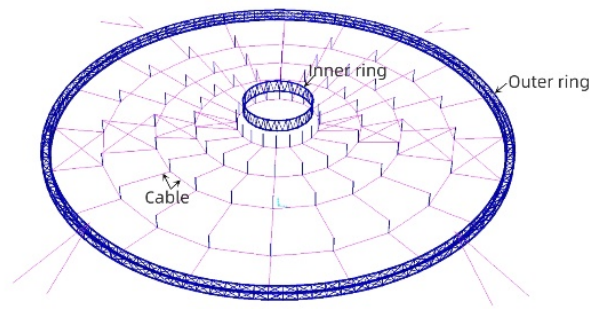
Figure 9. Schematic diagram of the cable structure.